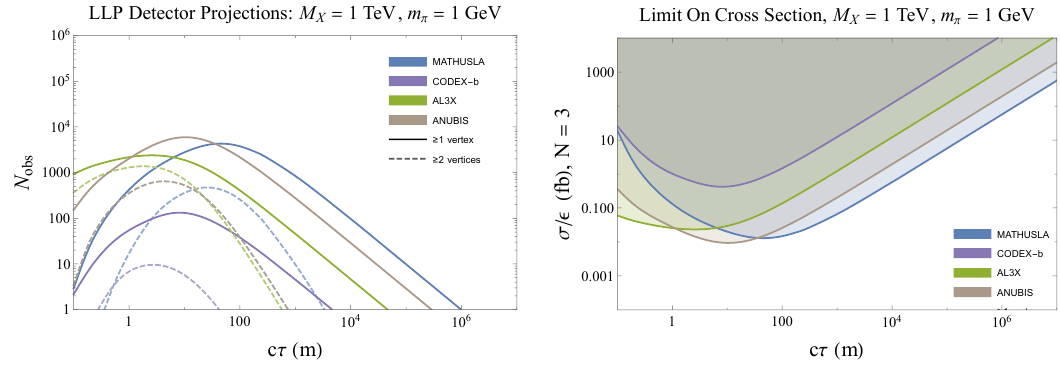
Figure 3 . Left: expected number of observed dark pion decays observed at the LLP experiments as a function of dark pion lifetime. Solid (dashed) lines correspond to observing one (two) or more decays within the detector region. Right: the 95% confidence upper bounds on the cross section per reconstruction efficiency (cid:15) DV , assuming a completely background-free experiment. Both figures are projections for m π = 1 GeV and M X = 1 TeV. d